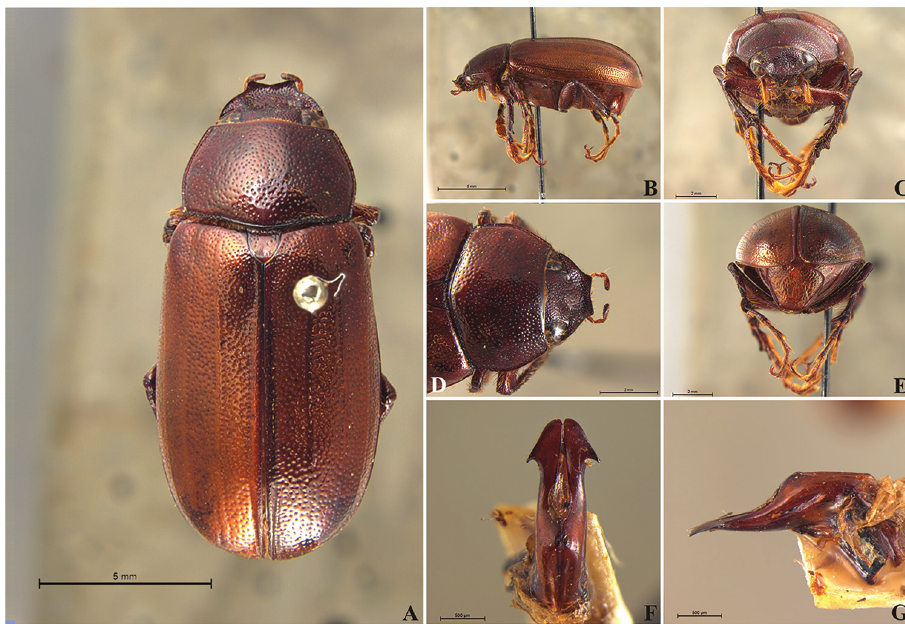
Figure 77. Liogenys tibialis Moser. A Dorsal view B Lateral view C Frontal view D Clypeus and prono- tum E Pygidium F Parameres, dorsal view G Parameres, lateral view.